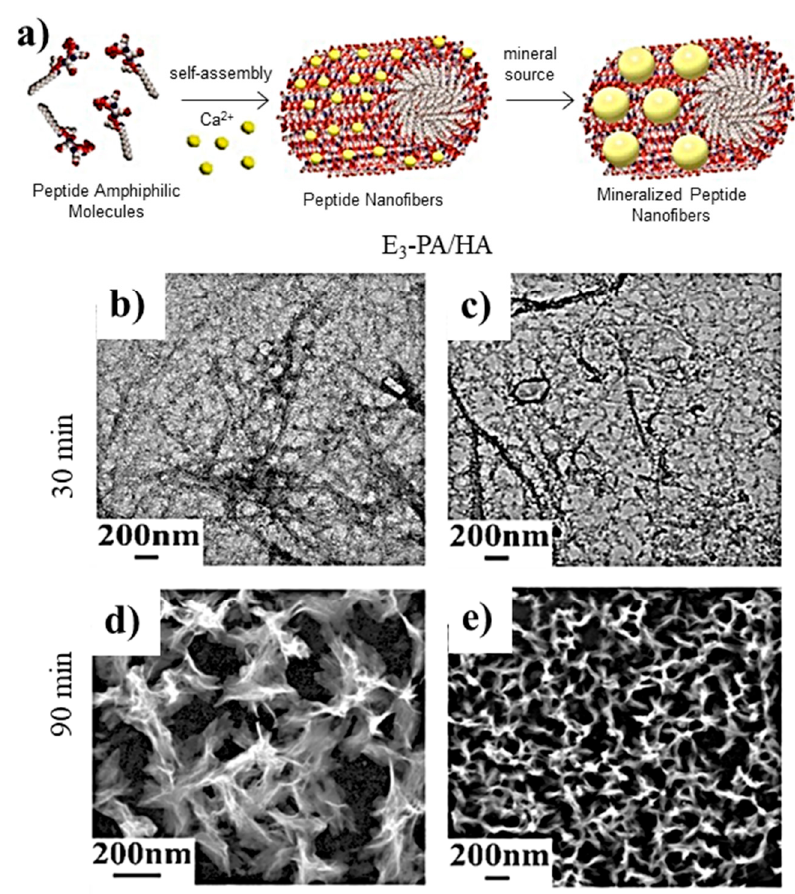
Figure 4. ( a ) Scheme showing the formation of nanofibers from peptide amphiphile molecules (PAs) and the subsequent mineralization. Micrographs taken after ( b , c ) 30 and ( d , e ) 90 min of calcium phosphate mineralization where nanofiber ( b , c ) and plate-like ( d , e ) morphologies are visible. Reproduced from [100].